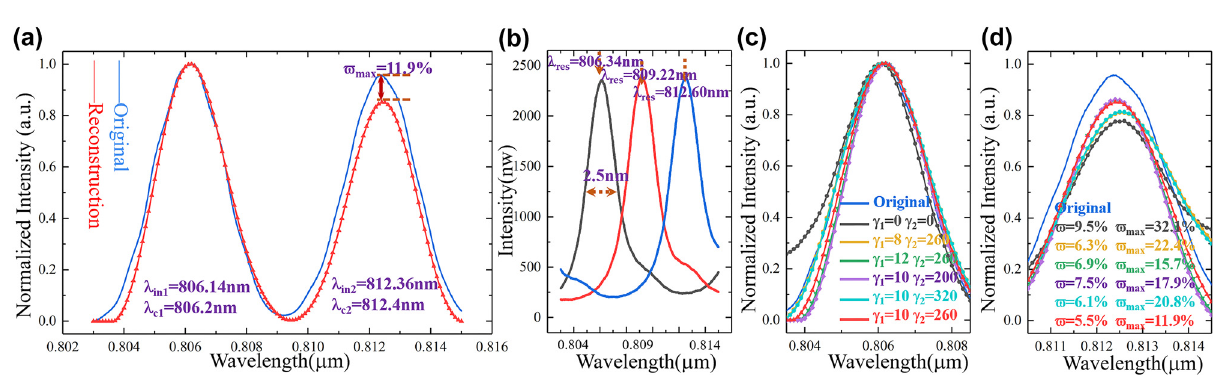
Figure 5: The reconstructed results of double broadband spectrum with three micro-rings. (a) The optimized reconstructed results of double broadband spectrum. (b) The system transmission spectra with FWHM of 2.5 nm. (c) and (d) The reconstructed spectrum with different optimized and 𝛾 ) and the corresponding reconstructed spectrum error is shown ( 𝜛 and 𝜛 coefficients ( 𝛾 1 2 incident spectrum and the red line is the optimized reconstructed